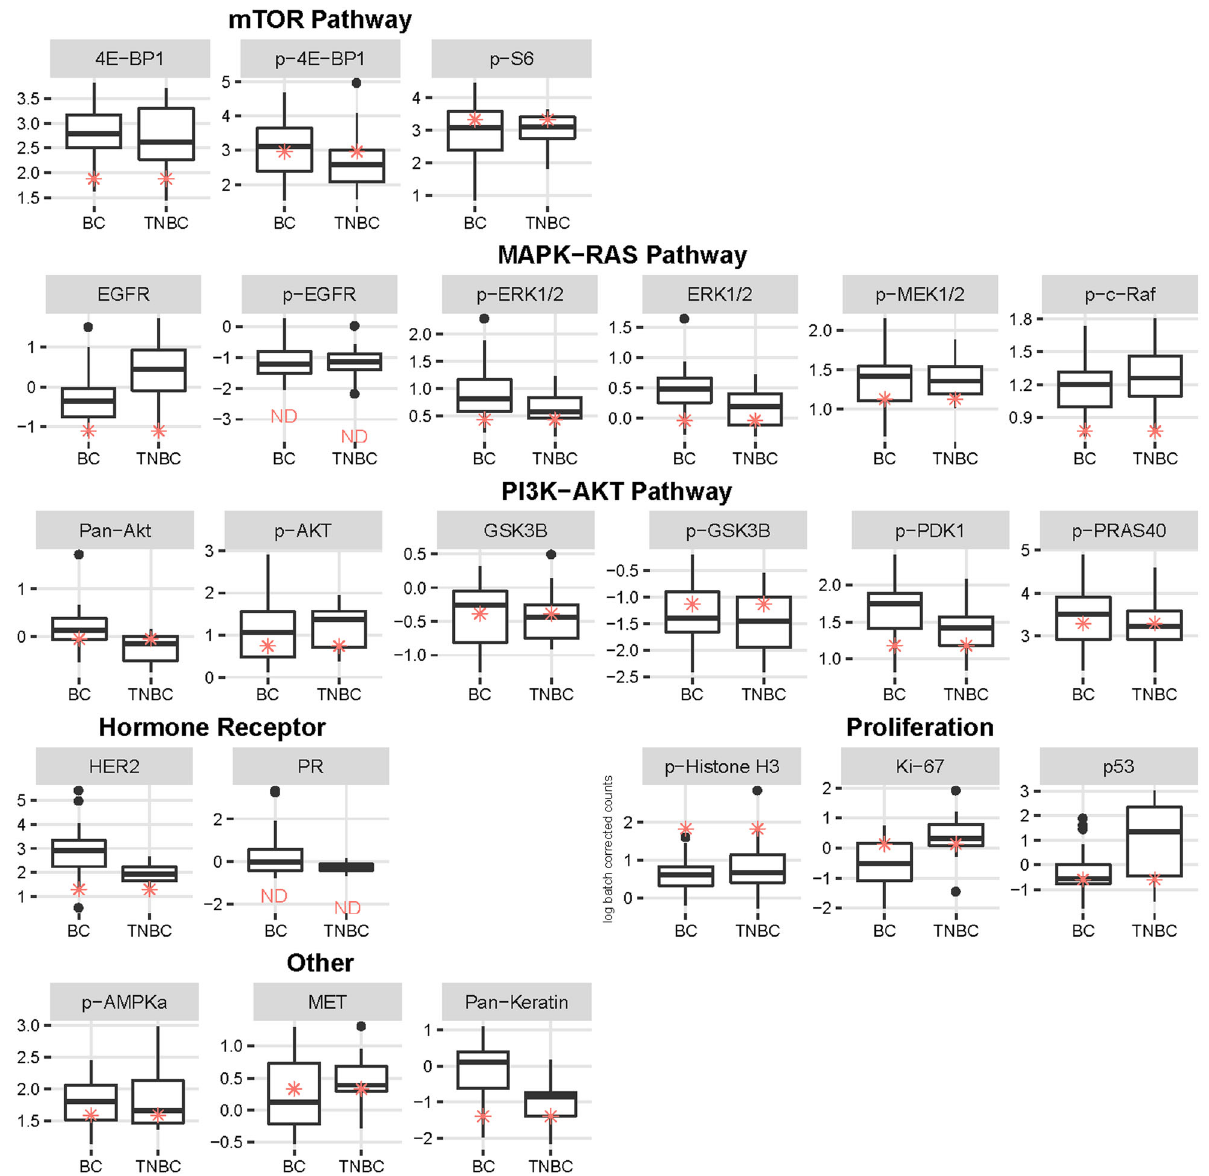
Fig. 3 Pathway analysis of protein and phosphoproteins within Study biopsy #2 by the Intracellular Signaling Protein Panel. Box and Whisker plots Y -axis showing the distribution of antibody levels (log batch correct counts) of Study biopsy #2 (red asterisks) compared to a cohort of 32 metastatic breast cancers of all subtypes (BC) or 15 metastatic TNBC specimens, X -axis. Cohort consists of predominantly HER2 negative samples. Boxes show the 25th, 50th (median line), and 75th percentiles of the cohorts. Protein and phosphoproteins are grouped under pathways including “ PI3K-AKT ” , “ mTOR ” , and “ MAPK-RAS ” , and the categories “ Proliferation ” and “ Other ” . ND = Not detectable or below level of background, measured with non-speci fi c